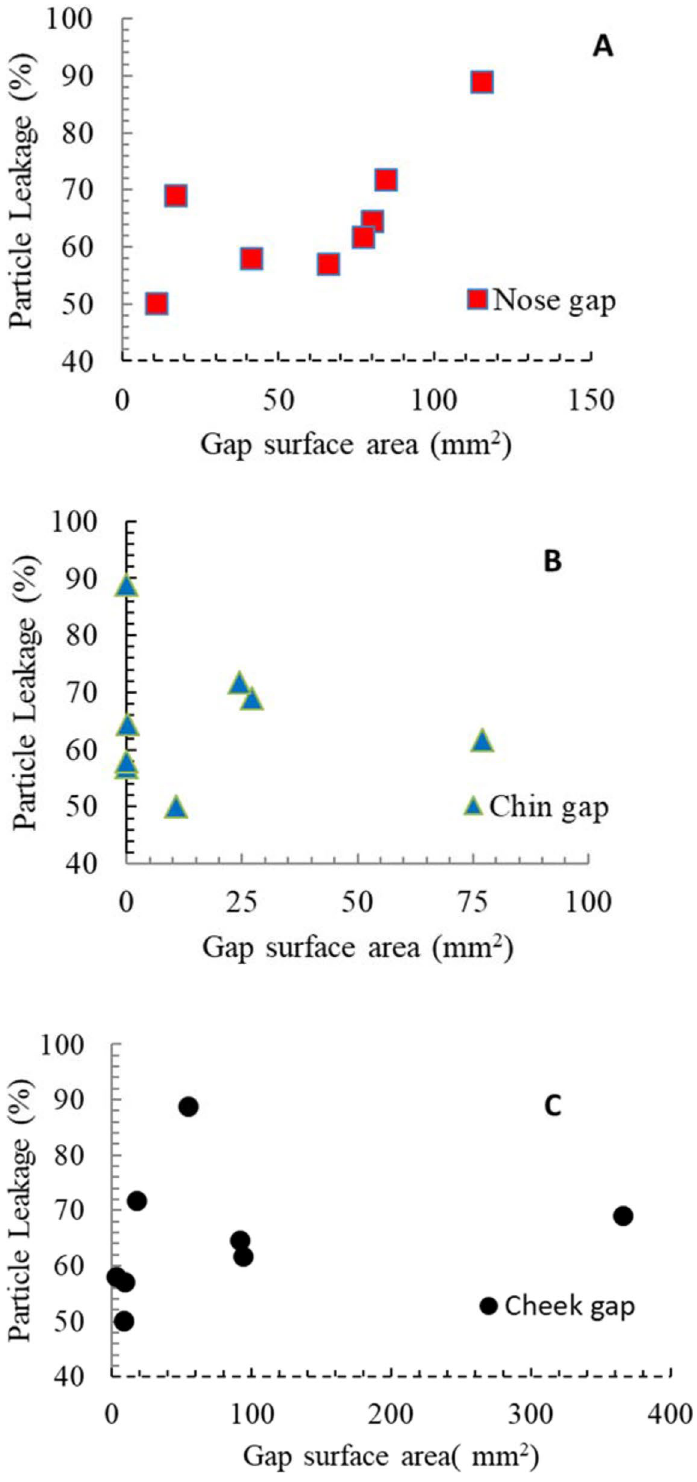
Figure 12. Variation of aerosol leakage as a function of ( A ) nose (R 2 = 0.48), ( B ) chin (R 2 = 0.005) and ( C ) cheek (R 2 = 0.05)